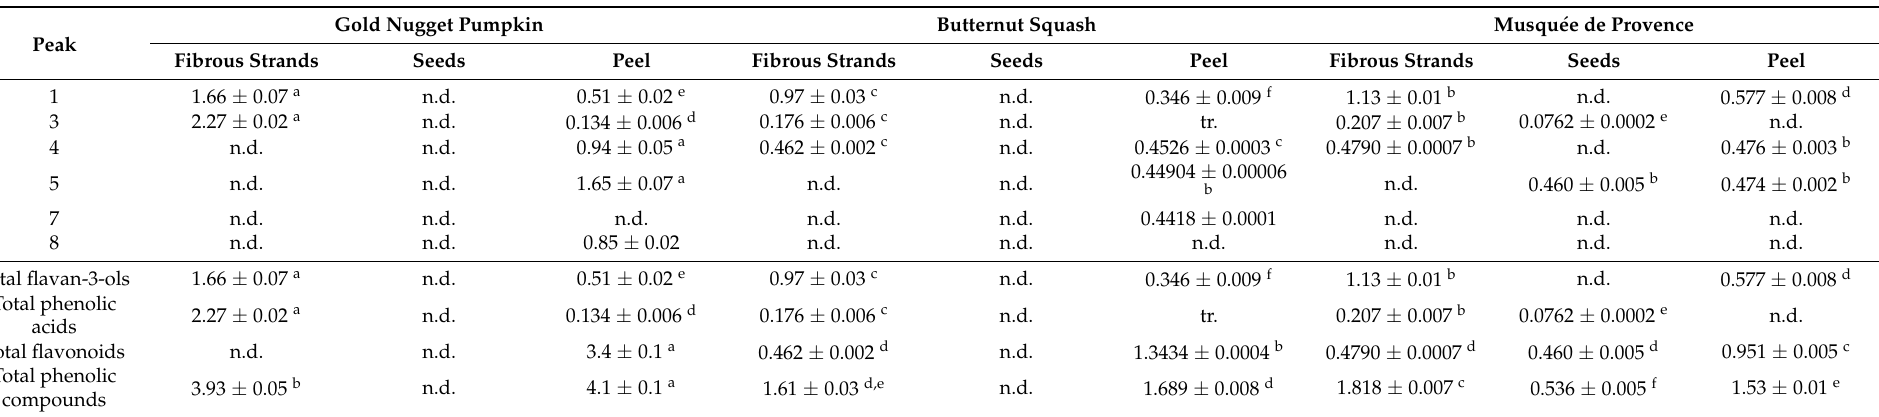
Table 3. Quantification of the phenolic compounds found in the pumpkin samples from Algeria (mg/g of extract).